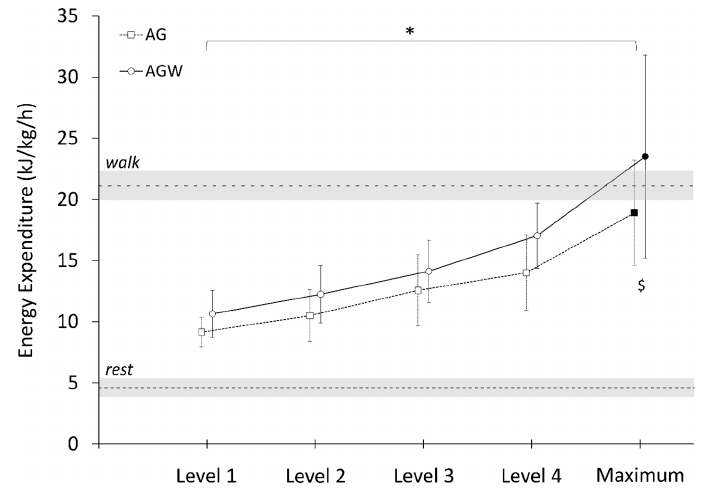
Figure 2. Relative energy expenditure (EE) across game levels (1–4) and maximum level attained (Maximum) in active gaming with (AG) and without added weights (AG W ). Rest and walk (W6) average values are represented in dashed lines with ± 1 standard deviation (greyed area). Symbol * represents the main significant effect of exercise, and symbol $ represents significant differences between AG and AG W ( p < 0.05).